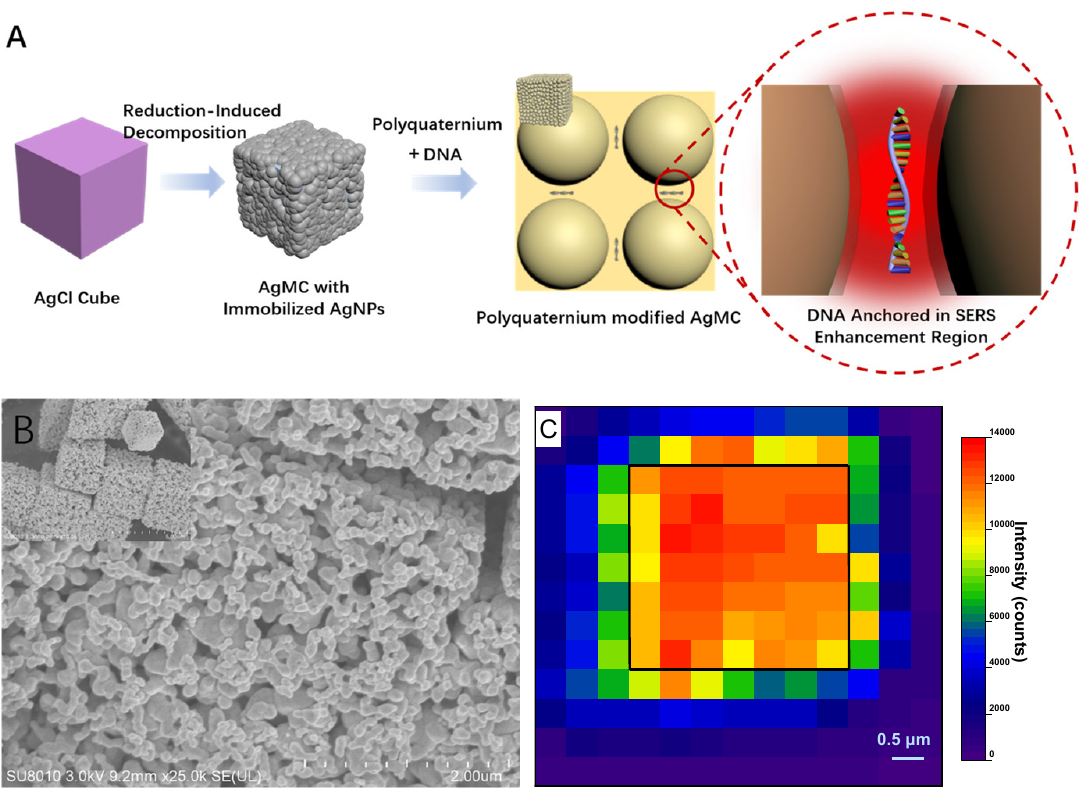
Figure 1. ( A ) Scheme of the synthesis and detection process of the poly@AgMC; ( B ) SEM image of the immobilized AgNPs stack on each other and dispersed on the surface; ( C ) SERS intensity mapping over an effective area of single AgMC (3 × 3 μm 2 ) at a Raman signal of 734 cm −1 .